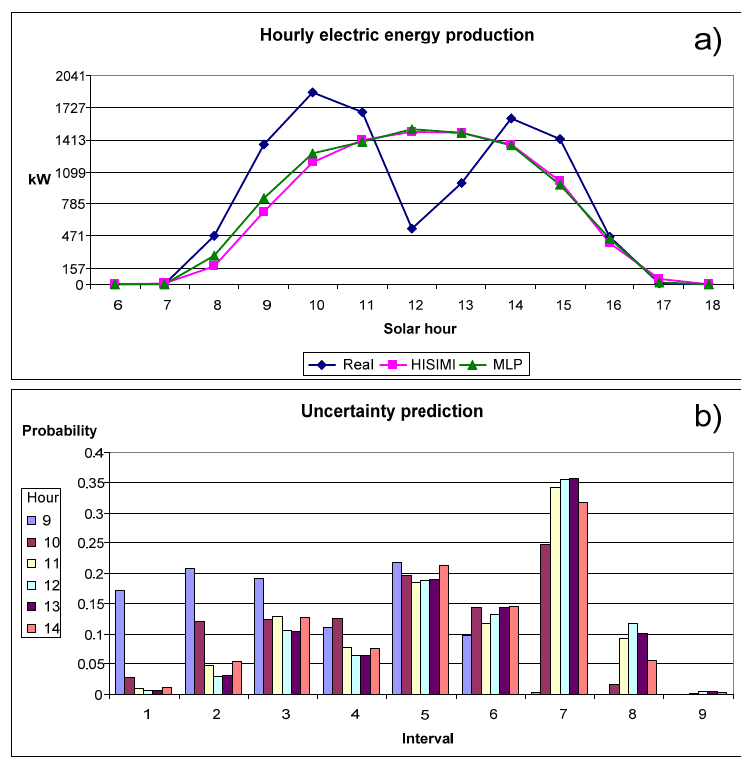
Figure 12. Forecasted hourly power production ( a ) and uncertainty prediction for six central hours; ( b ) (from 9:00 to 14:00) on a cloudy and rainy